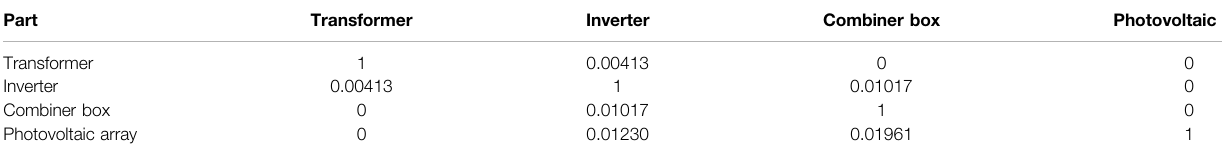
TABLE 4 | Correlation coef fi cient of the actual degradation. Part